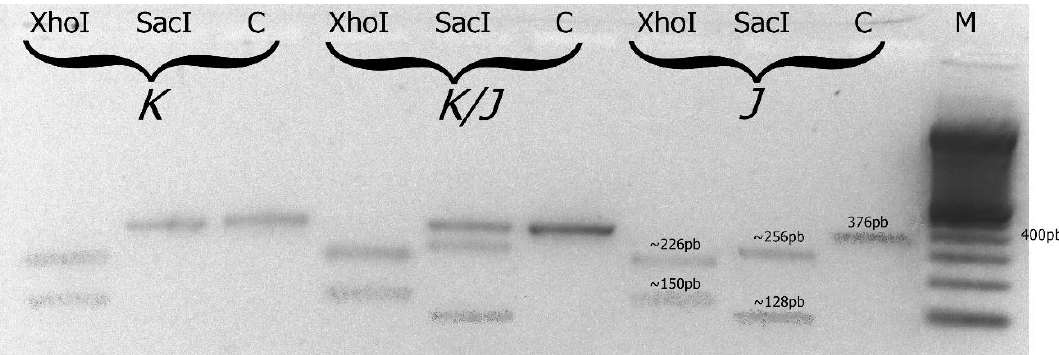
Fig 2. Results from restriction fragment analysis (PCR-RFLP) of partial COI region (376 bp). M = marker; C = Control (PCR result without any enzyme); SacI = restriction enzyme with cleavage site for haplotype differentiation (K and J); XhoI = restriction enzyme with cleavage site for V. destructor differentiating it from V. jacobsoni